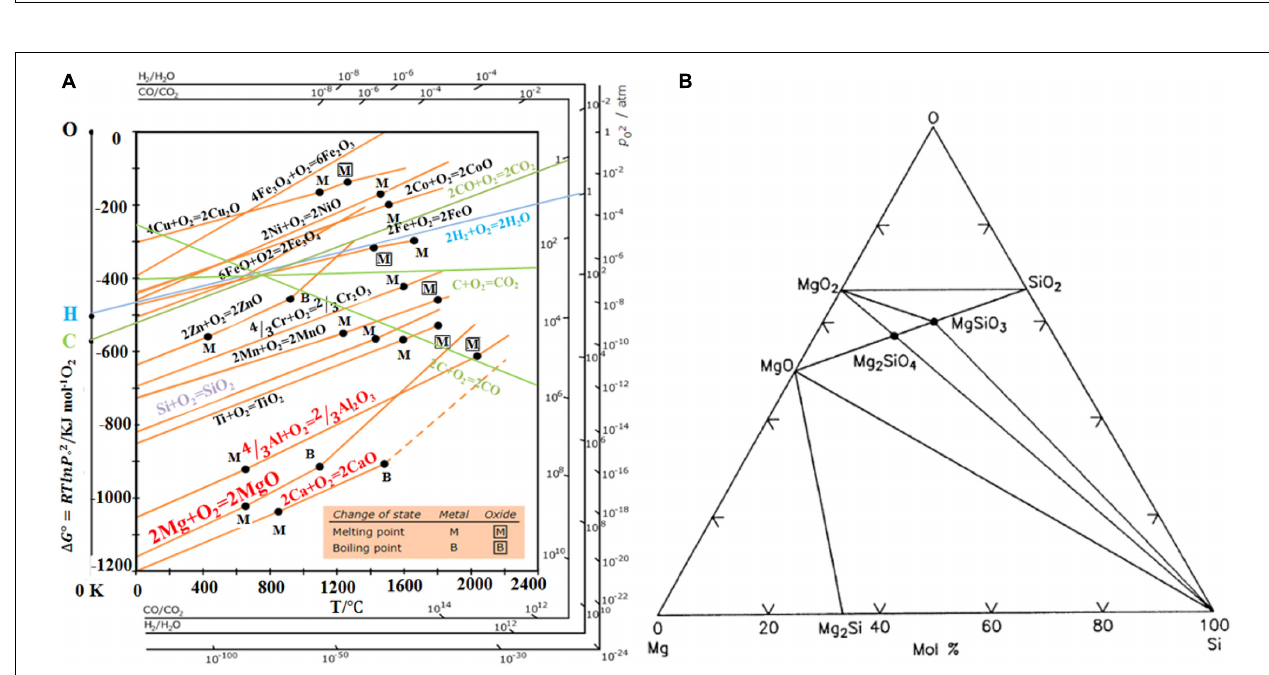
FIGURE 2 | (A) Ellingham diagram of different oxides. Reprinted from Ref. (Ellingham, 1944), with the permission of Wikimedia Commons. (B) Calculated Si–O–Mg phase equilibria at 25 ◦ C. Reprinted from Ref. (Zhang et al., 2010), with the permission of John Wiley and Sons.